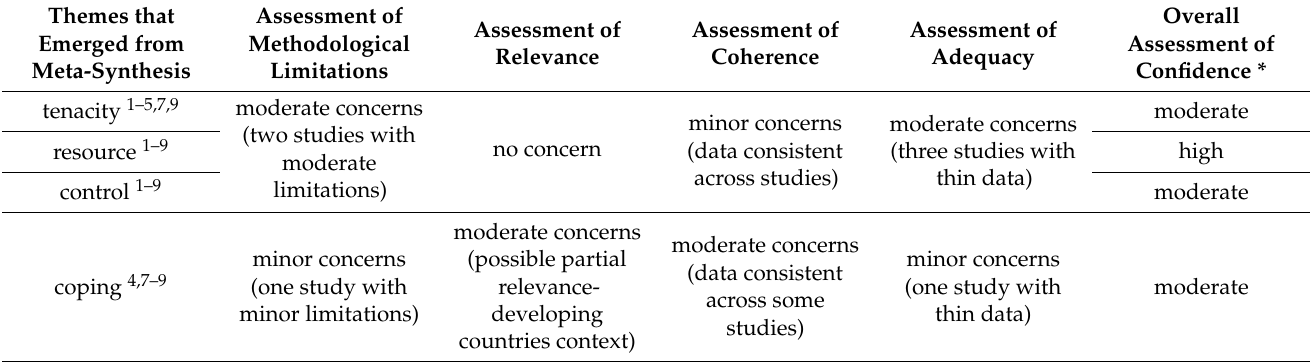
Table 4. Quality assessment of the themes derived from the